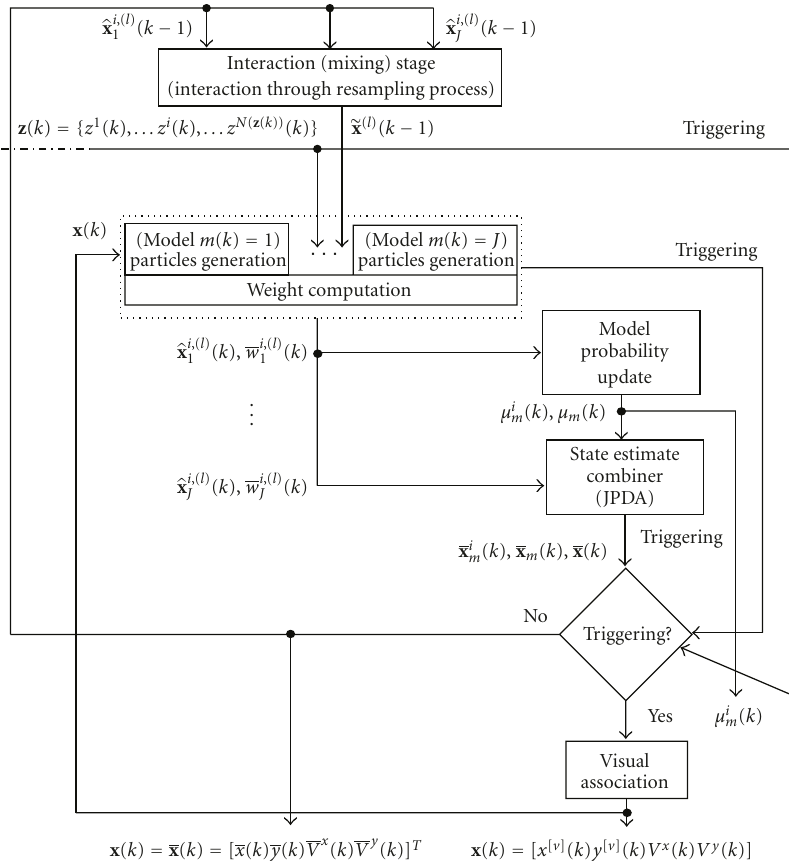
Figure 2: IMM-PF data flow and the visual sensor